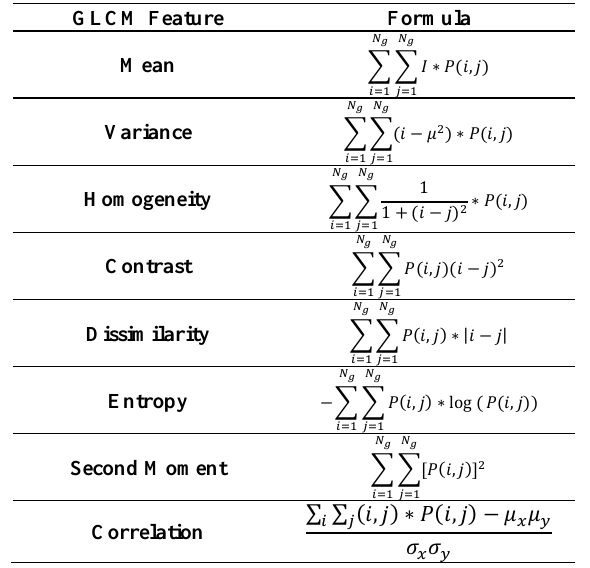
Table 1. GLCM features computed from the vegetation